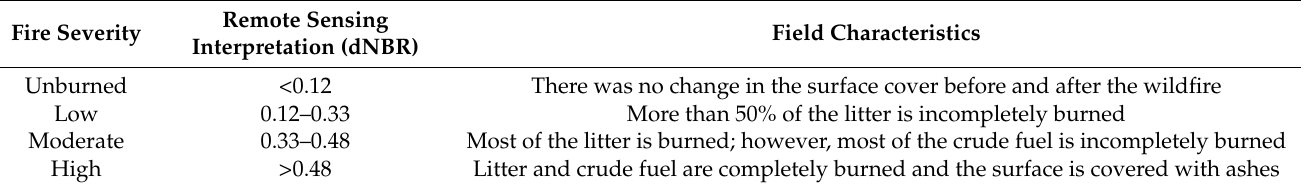
Table 2. Identification criteria of fire intensity in the burnt area: remote sensing interpretation and field investigation of fire intensity